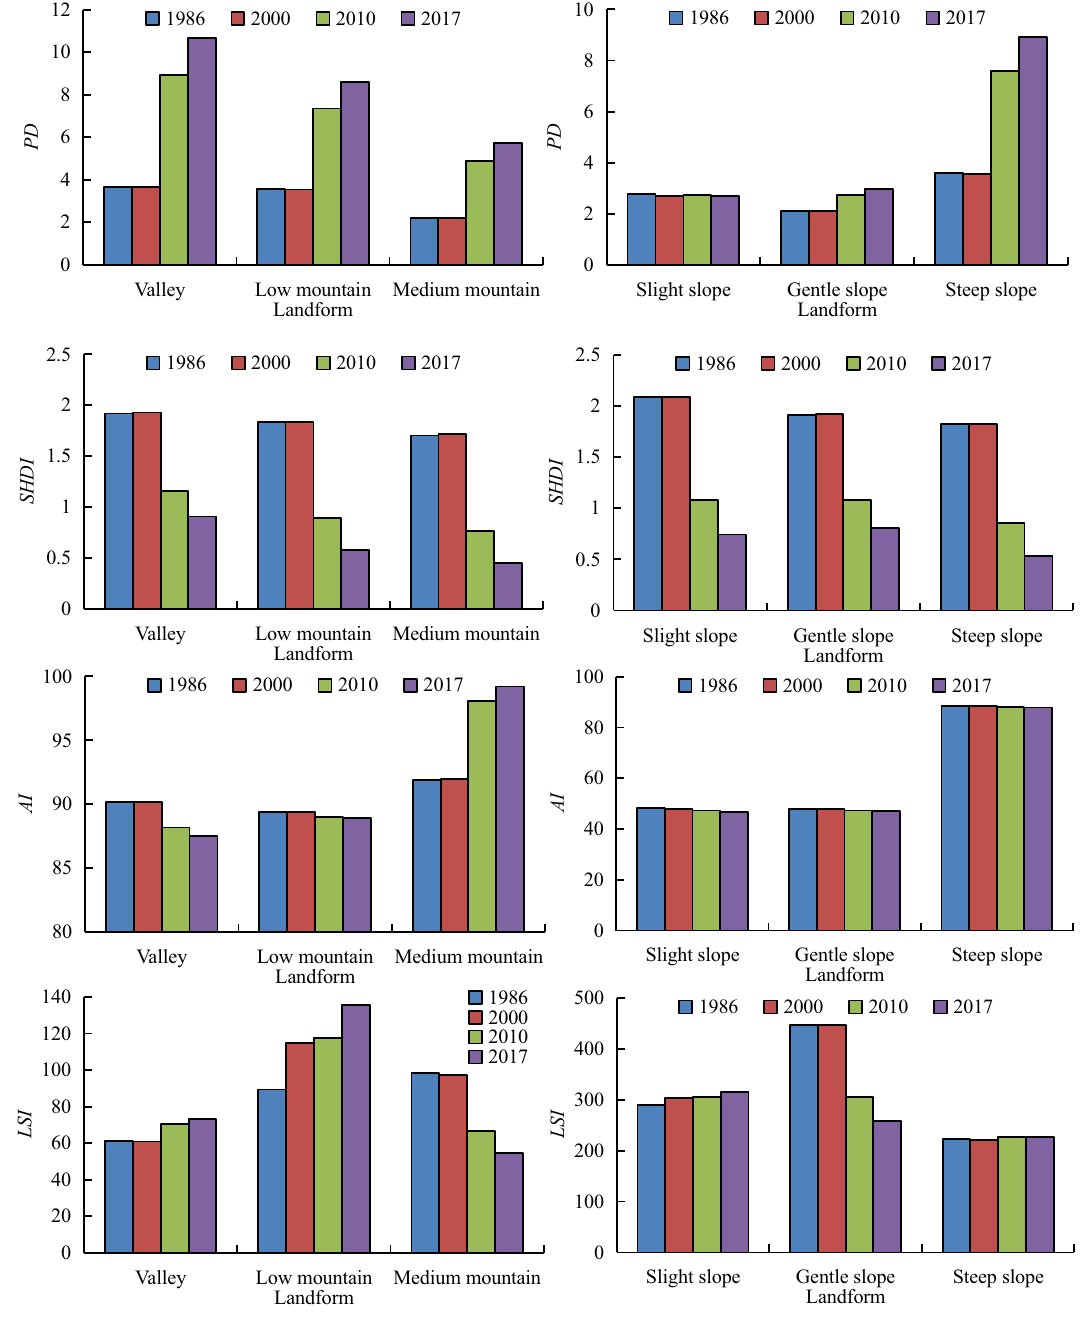
Figure 9. Changes in landscape index along with landforms from 1986 to 2017 in the